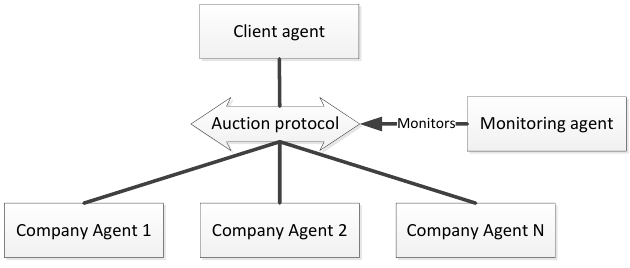
Fig 1. The structure of the multi-agent system.